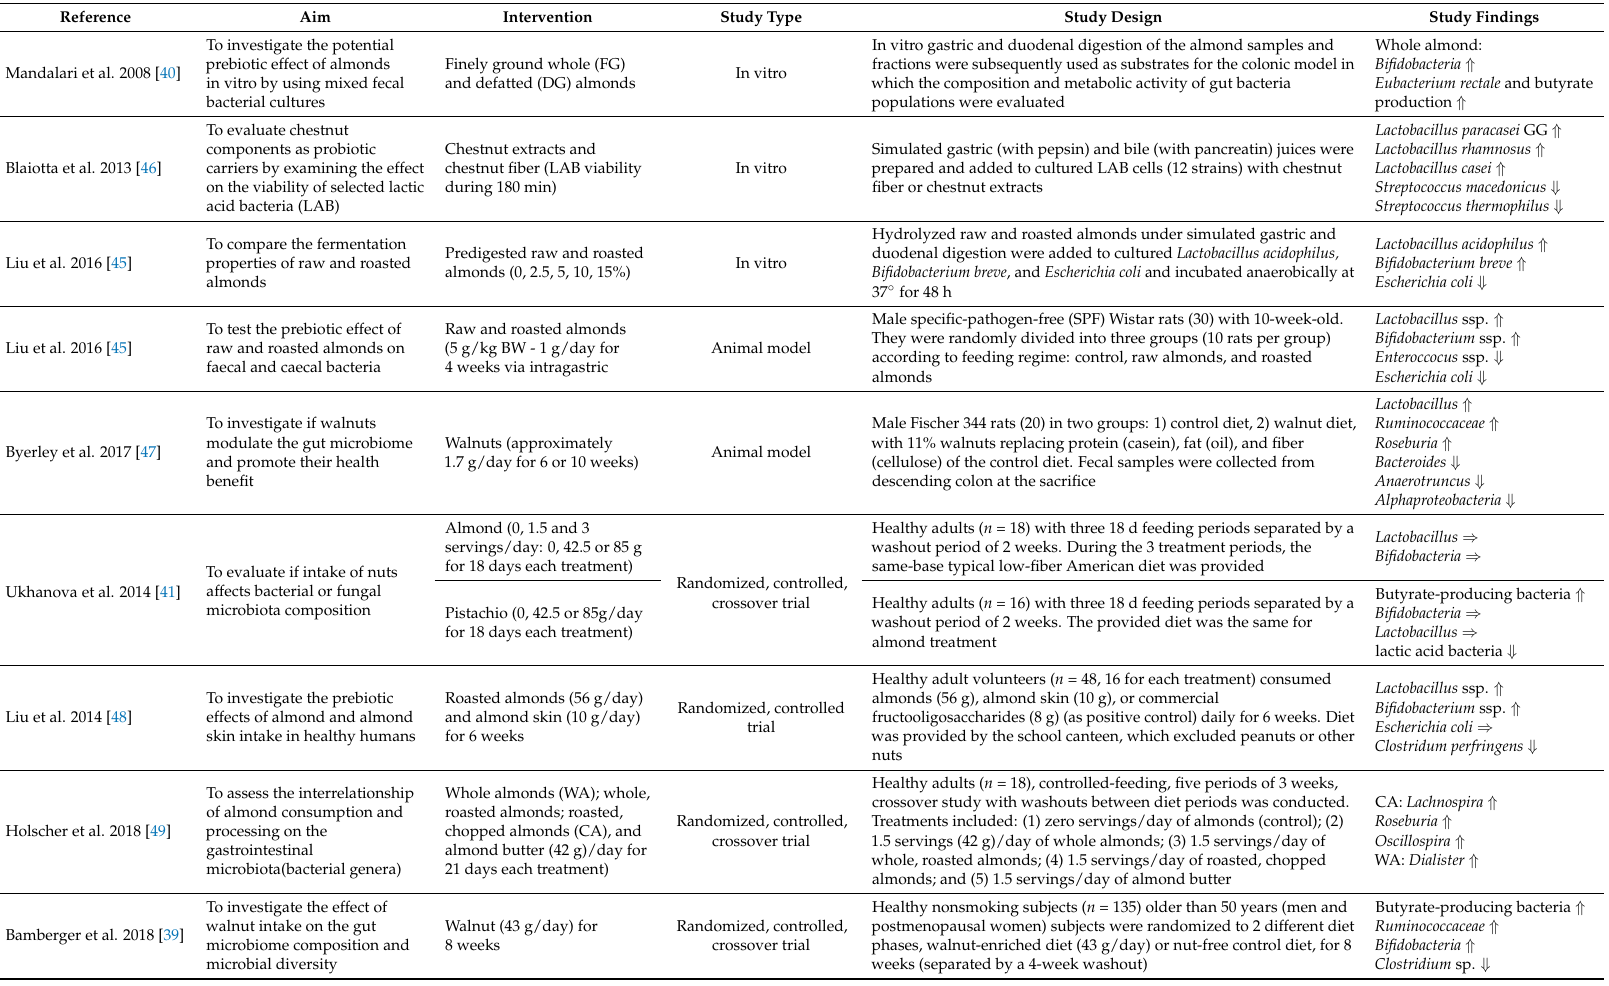
Table 3. Effect of nuts on the remodeling of gut microbiota in vitro, in animal models, and in human